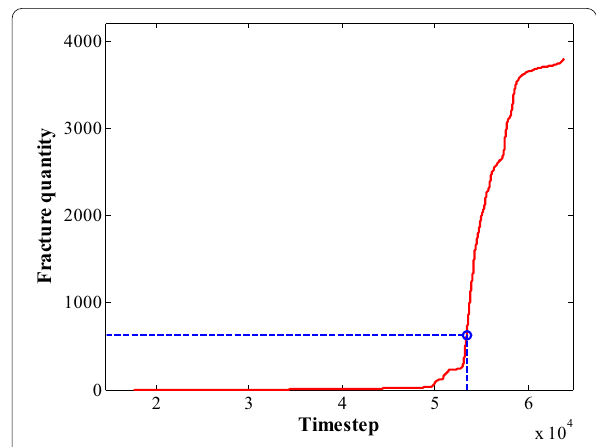
Fig. 15 Increasing process of the fracture quantity in the